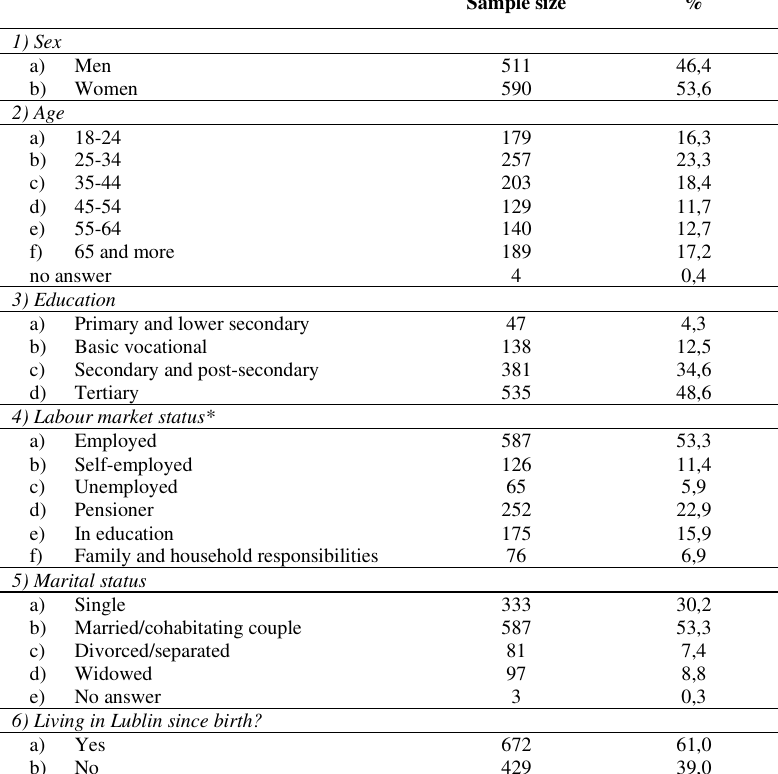
Table 1. Sample characteristics